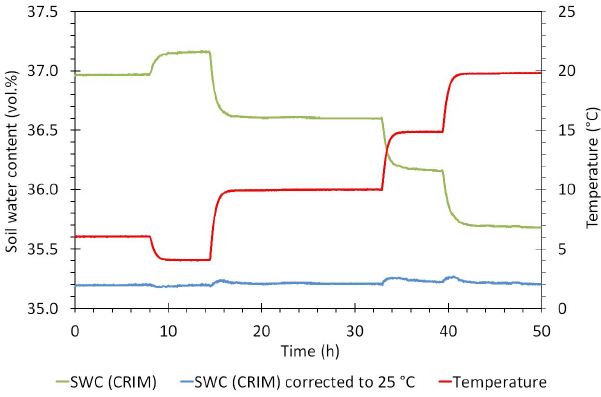
Figure 5: Figure 4. The average temperature and soil water content response of three SMT100 sensors. Soil water content was derived from measured apparent permittivity using the complex refraction index model (CRIM) and the temperature correction was done using the temperature dependence of the dielectric permittivity of water reported by